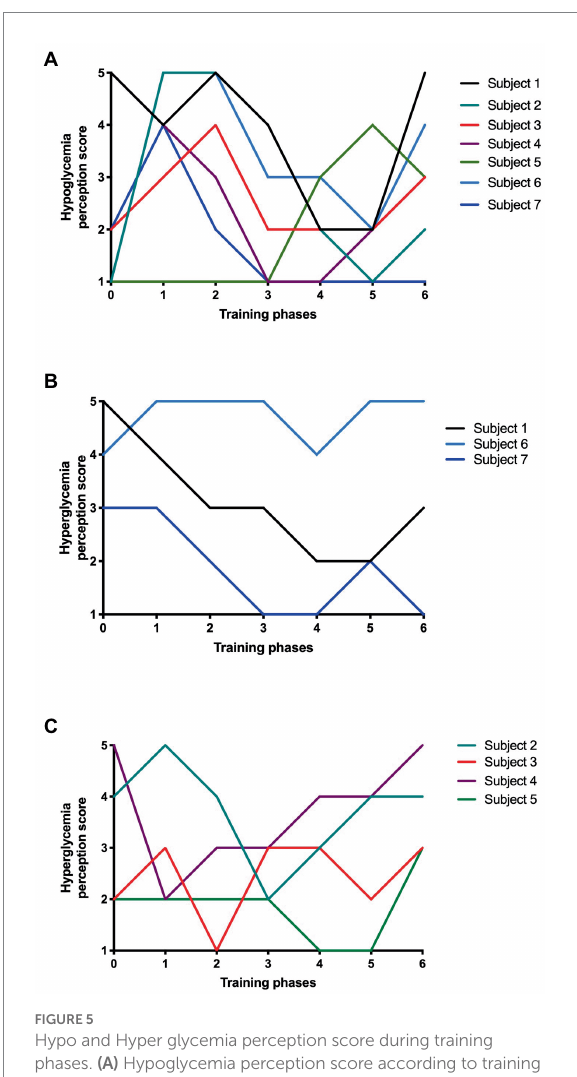
FIGURE 5 Hypo and Hyper glycemia perception score during training phases. (A) Hypoglycemia perception score according to training phases for all enrolled subjects ( n = 7); (B) Hyperglycemia perception score for women ( n = 3); and (C) males ( n = 4) according to training